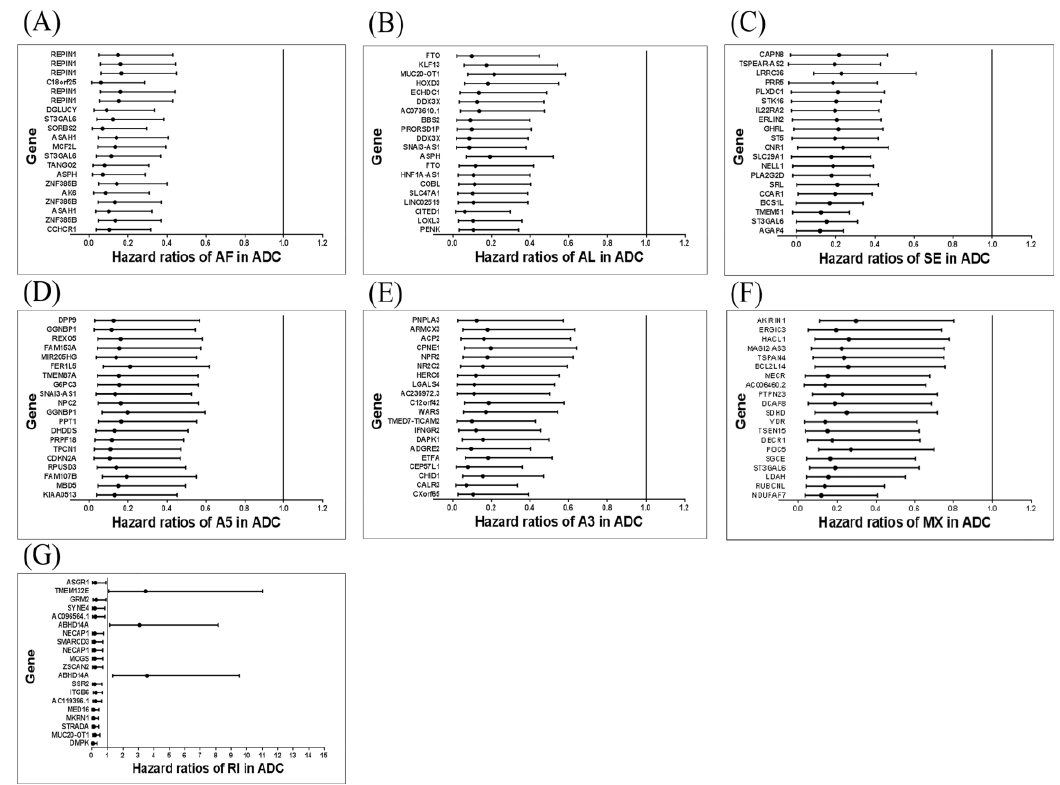
Figure 3. Forest plots for OS-related AS events in each subgroup. ( A – G ) Forest plots of hazard ratios (HRs) for the top 20 OS-related AS events in retained intron (RI), skipping exon (SE), alternative 5’ splice site events (A5), alternative 3’ splice site events (A3), alternative first exons (AF), alternative last exons (AL) and mutually exclusive exons (MX)